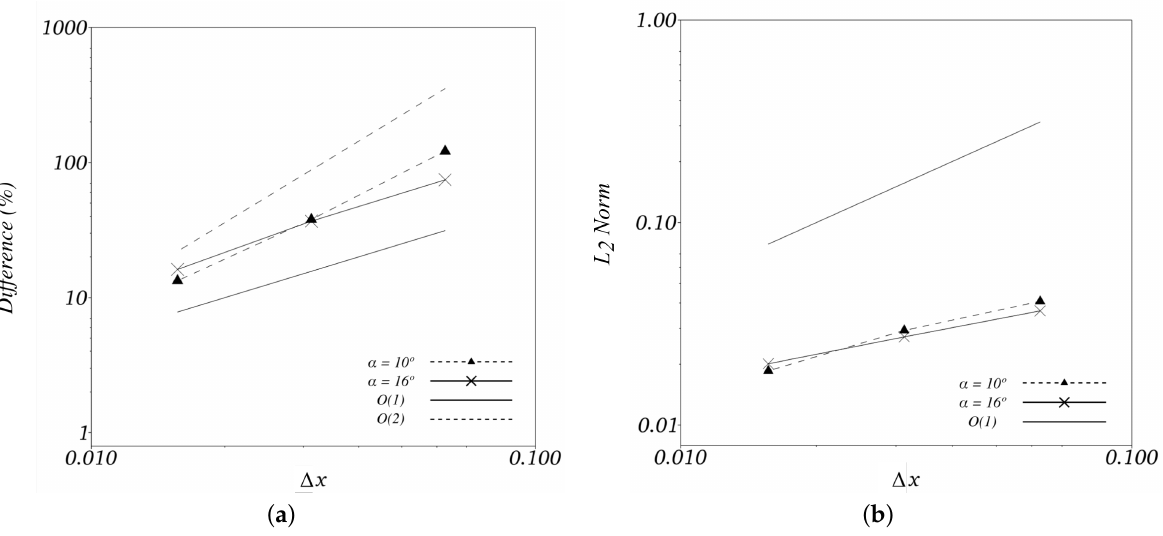
Figure 8. Order of spatial convergence. ( a ) Decay as a function of the relative percentage difference of mean C d in relation to the work of [42]. ( b ) Decay as a function of the time average of the L 2 norm of the horizontal Lagrangian